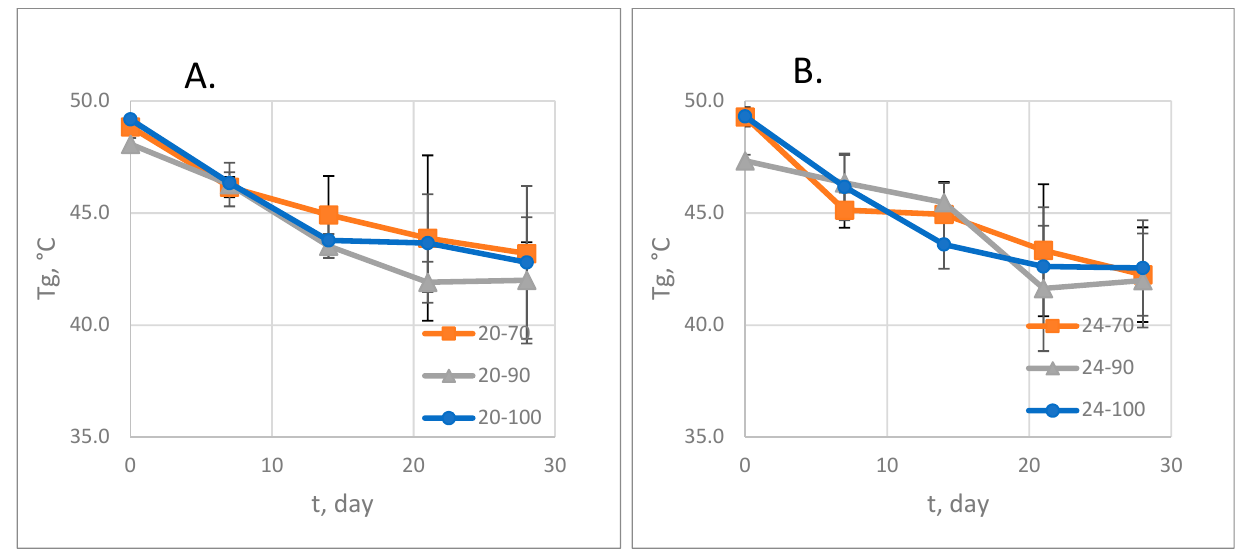
Figure 4. Trends of PLGA glass transition temperatures. ( A ): 20—70, 20—90, 20—100 formulations; ( B ): 24—70, 24—90, 24–100 formulations.